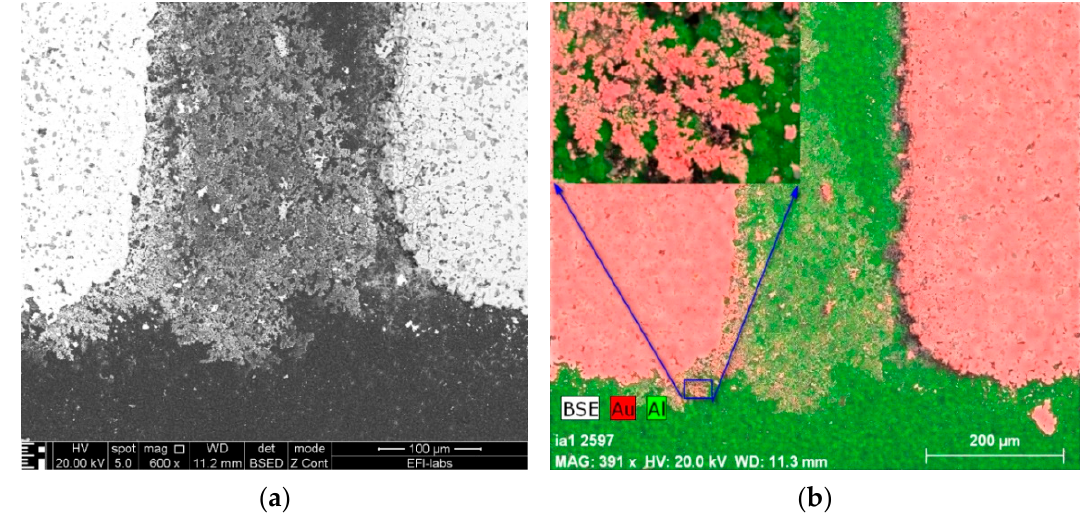
Figure 5. SEM micrographs of the structure shown in Figure 3: ( a ) backscattered electron micrograph; ( b ) backscattered electron micrograph with a color overlay representing the elemental distribution by X-ray mapping (Au red, Al green), (with 5 V bias).